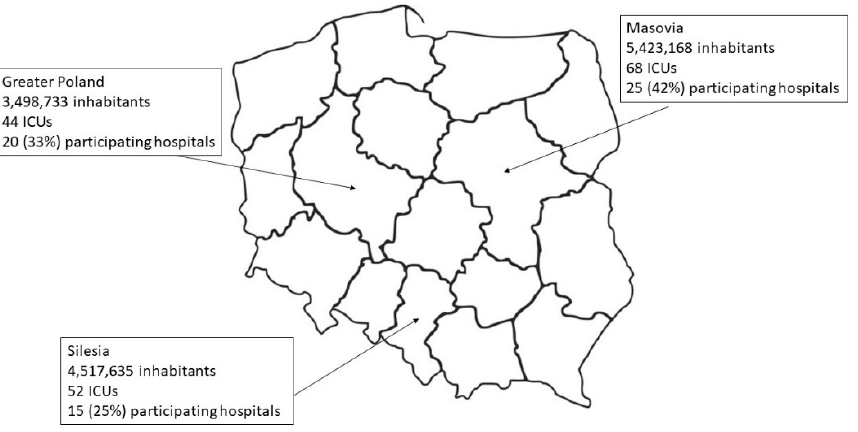
Figure 1. Study group origin and demographics.